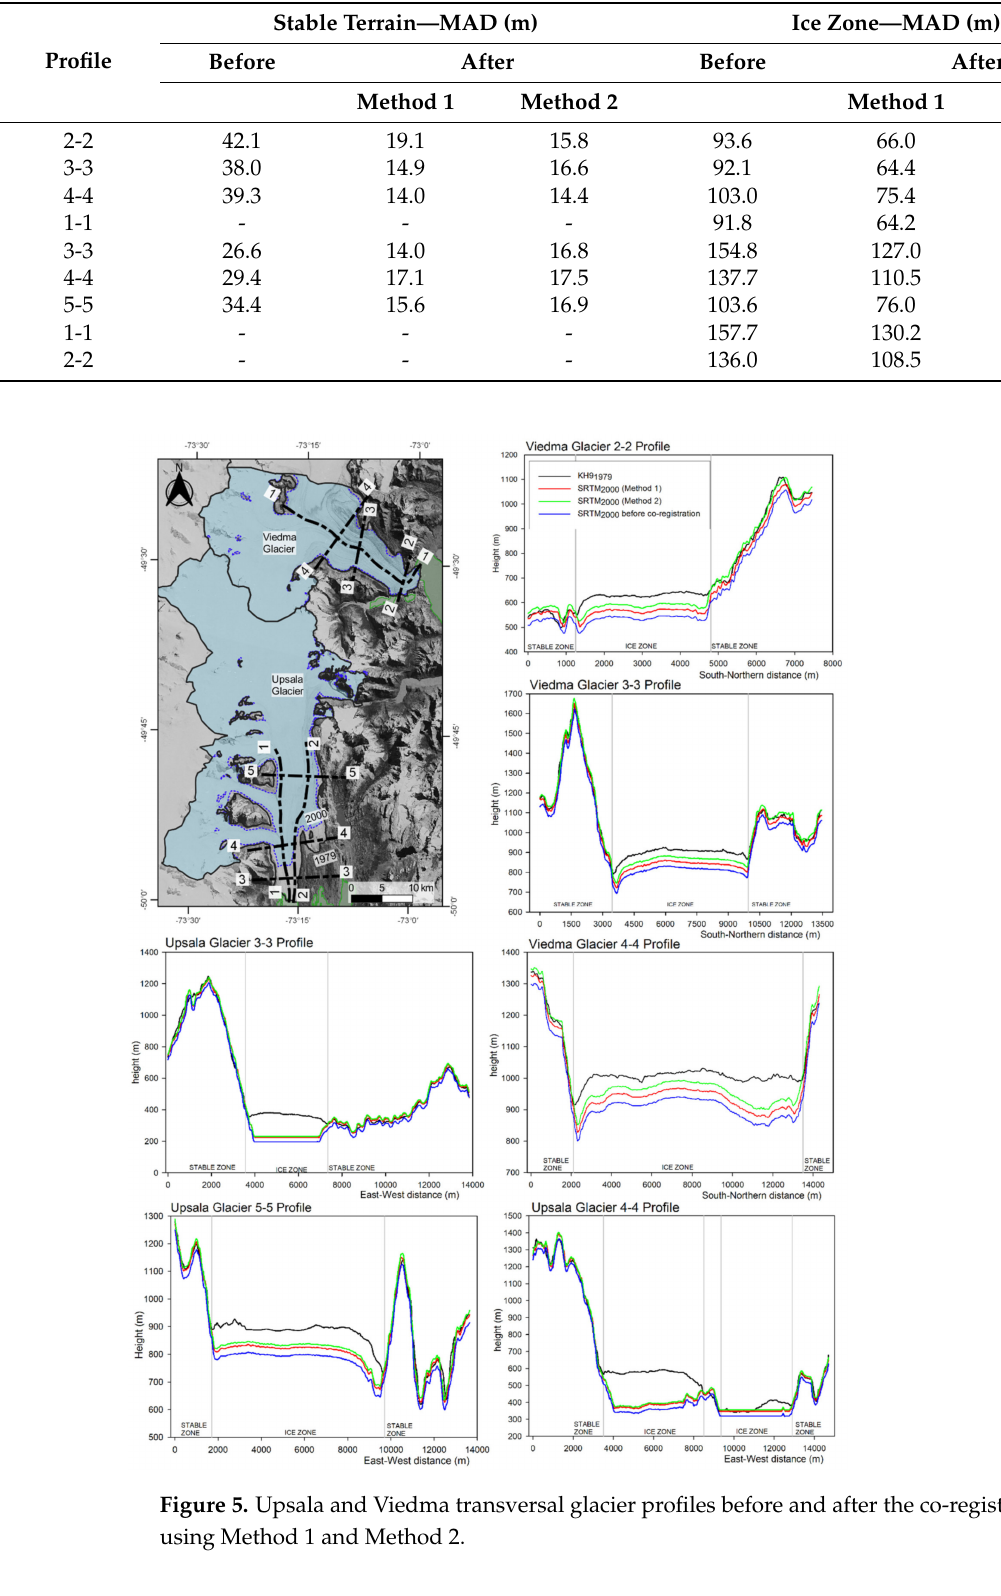
Table 7. Glacier elevation change statistics obtained from profiles before and after applying co- registration methods. The MAD between SRTM 2000 –KH9 1979 elevations is presented for each profile in Figure 5, separating stable from ice zone.